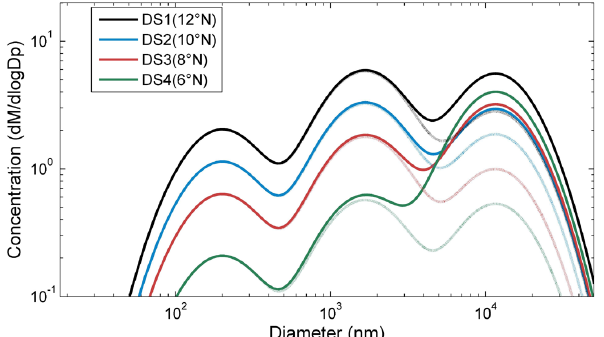
Fig. 11. Mass size distribution for the SED simulation (line) and the NOSED simulation (dashed line) of dust particles transported in the Saharan Air Layer (SAL), at 2000m, for different latitudes (12 ◦ N, 10 ◦ N, 8 ◦ N, 6 ◦ N) at 12:00UTC on 13 June.